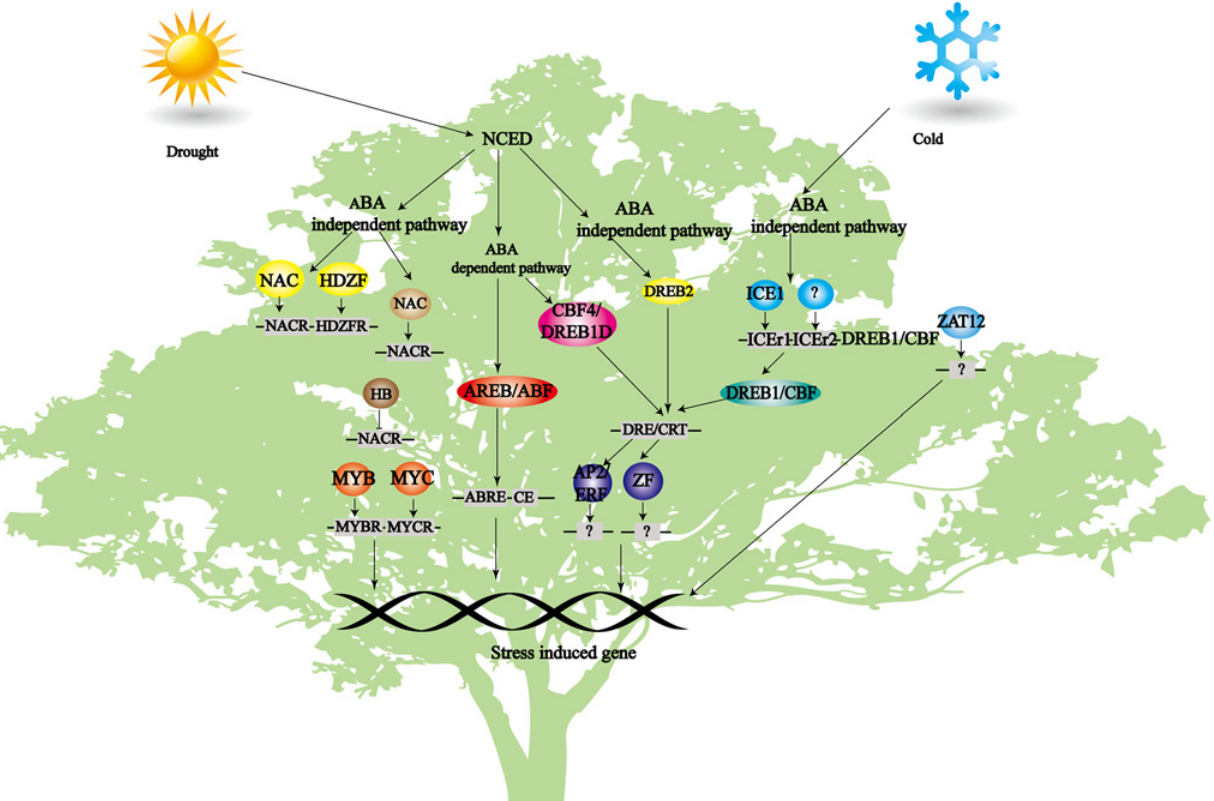
Fig 9. Stress response genetic network in S. sebiferum . ABA-dependent and ABA-independent pathway work together to response drought and cold. Identified transcription factors included MYC , MYB , NAC and DREB .